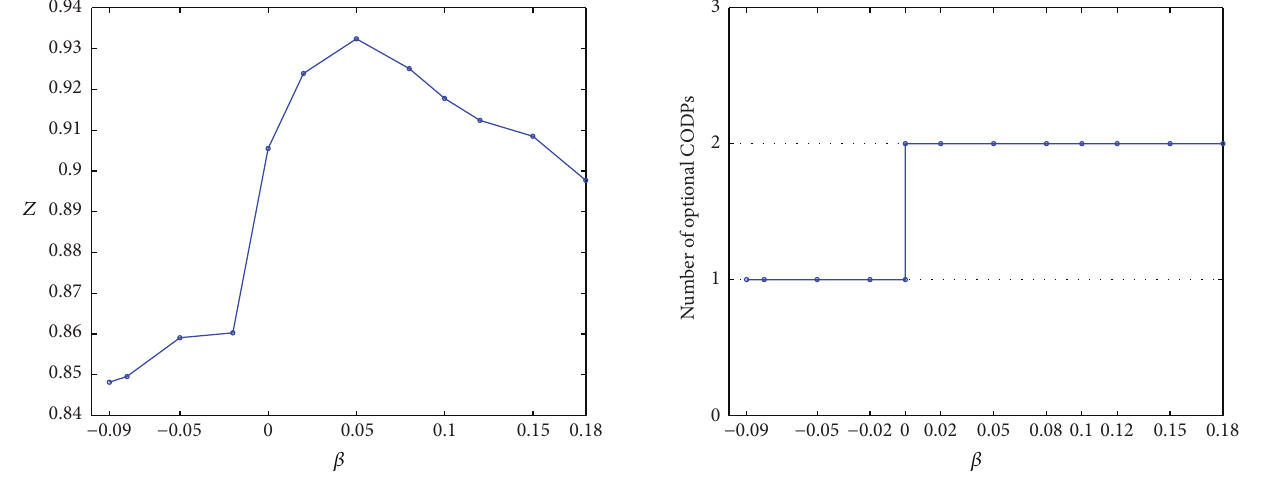
Figure 5: Curve of 𝑍 changed with 𝛽 . Figure 6: Curve of the number of optional CODPs with 𝛽